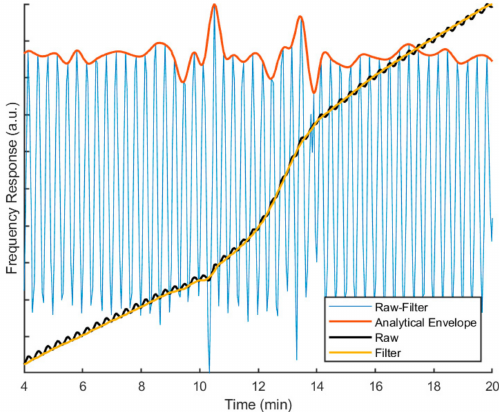
Figure 4. Overview of the applied deconvolution process. See manuscript description for more